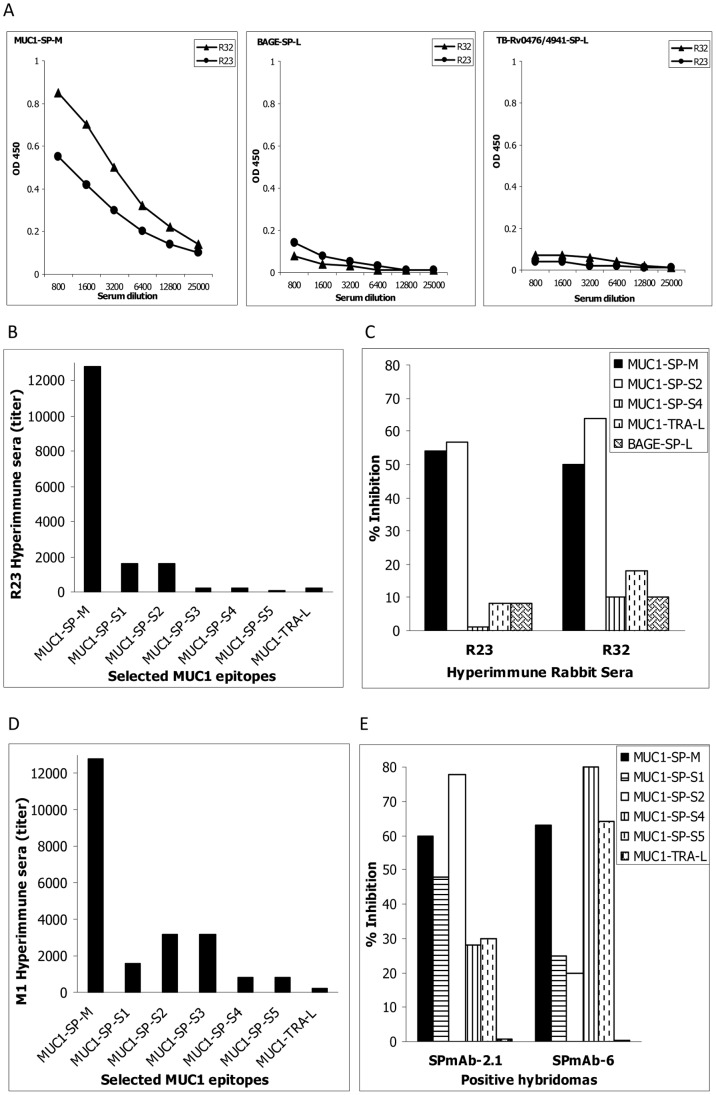
Generation of MUC1 SP-specific antibodies.The specificity and defined minimal epitope of the generated anti-MUC1 SP polyclonal antibodies (A–C) and mAbs SPmAb-2.1 and SPmAb-6 (D–E) were evaluated against the immunizing peptide MUC1-SP-M and its internal epitopes MUC1-SP-S1 to S5, in ELISA assays. MUC1's TRA epitope, MUC1-TRA-L, and the non-MUC1 SP domain BAGE-SP-L, were used in these assays as negative controls.